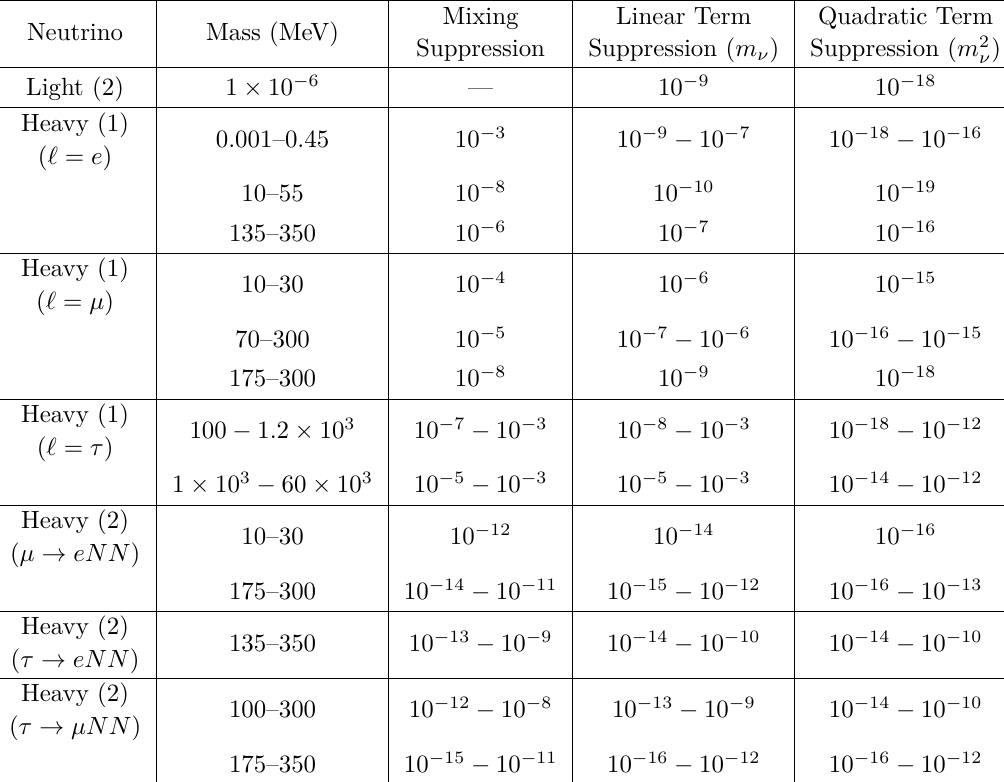
Table 4. Estimation of neutrino mass dependent terms